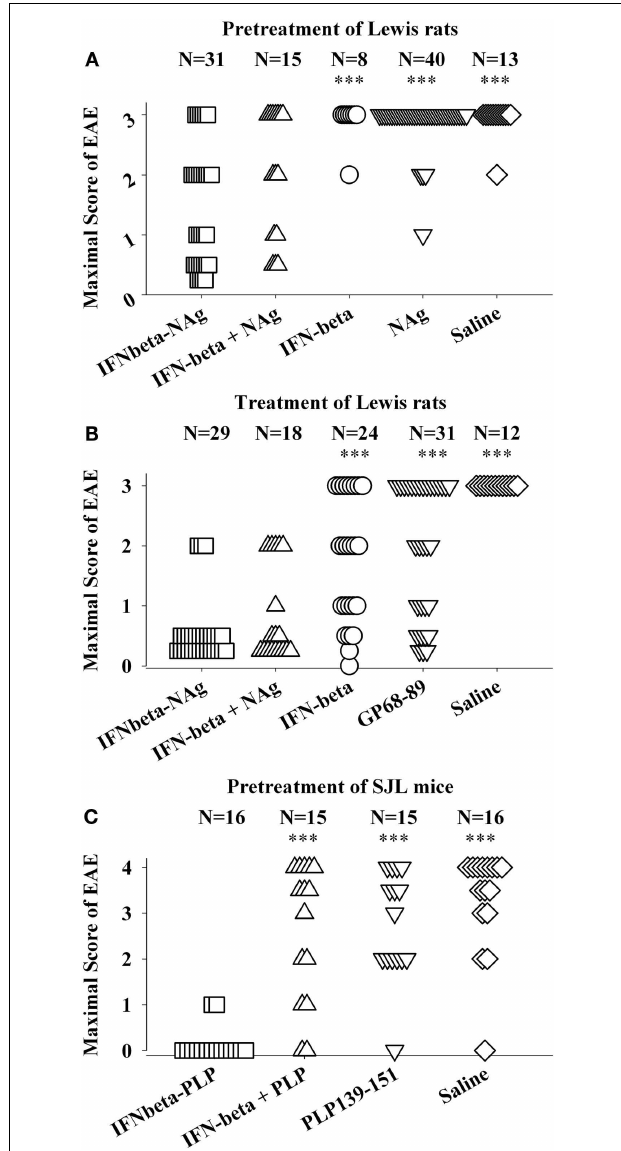
FIGURE 4 | IFNbeta-NAg vaccines were effective tolerogens in the Lewis rat and SJL models of EAE. EAE was elicited in Lewis rats or SJL mice by injection of the respective NAg in CFA on day 0. Designated cytokine-NAg proteins or control proteins ( x -axis) were given as pre-treatments on days-21, -14, and -7 (A,C) or alternatively were given as treatments after the onset of paralytic EAE (B) .Vaccines were injected subcutaneously in saline.The data analysis for experiments shown in (A,B) was previously reported inTables 2 and 4 (pre-treatment) andTables 4 and 5 (treatment) in Mannie et al. (2009b). In the pre-treatment protocol (A) , Lewis rats that were given the combination of IFNbeta + MBP69–88 as separate injections in adjacent subcutaneous sites had significantly less severe EAE than rats treated with MBP69–88 alone ( p = 0.001) or saline ( p = 0.011). In the treatment protocol (B) , Lewis rats that were given the combination of IFNbeta + MBP69–88 as separate molecules had significantly less severe EAE than rats treated IFN-beta alone ( p = 0.001), MBP69–88 ( p < 0.001), or saline ( p < 0.001). (*** p ≤ 0.001; ** p ≤ 0.01; * p ≤ 0.05 for comparison of the respective treatment groups to that of